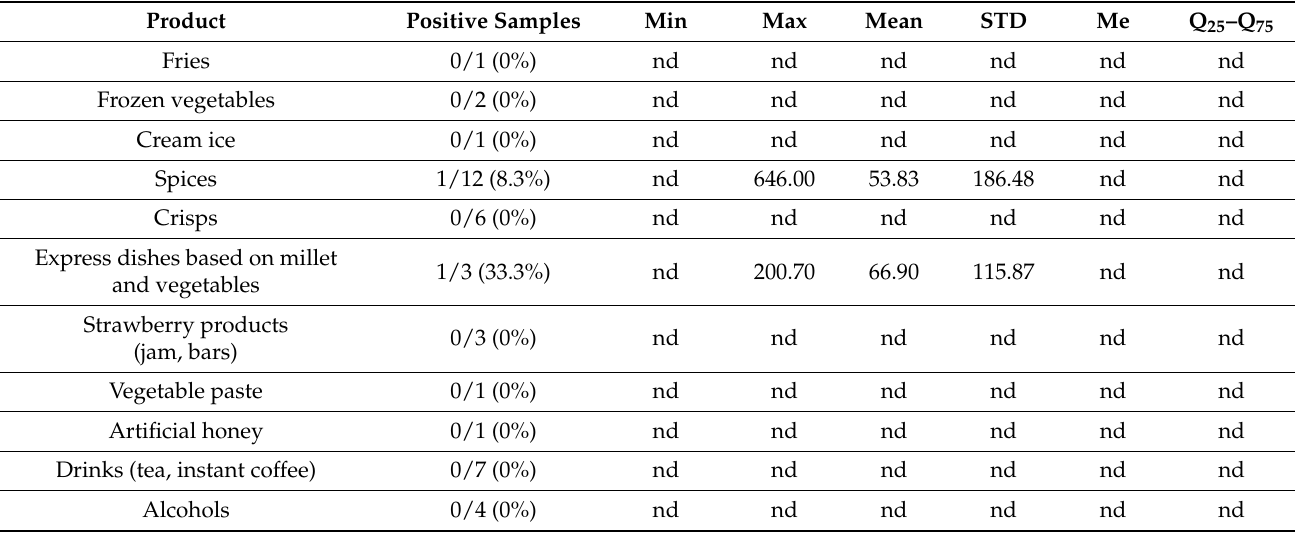
Table 2. The level of gluten contamination of naturally gluten-free products that do not have an indication on the label about the possible presence of gluten proteins